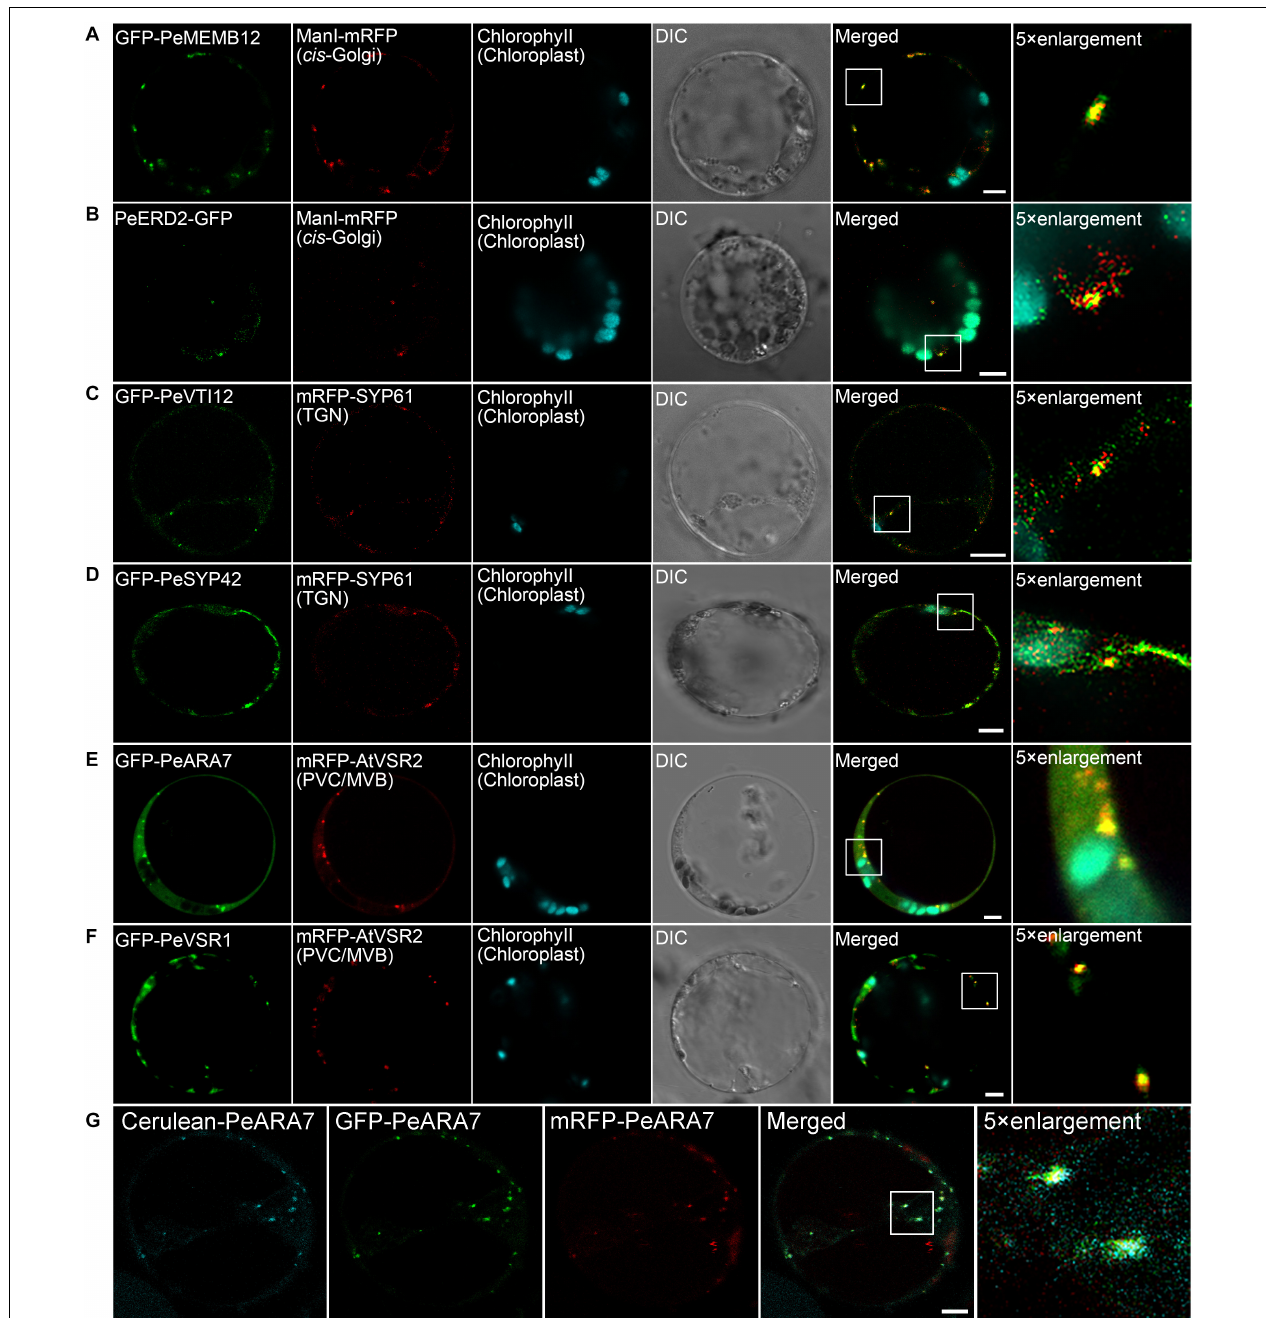
FIGURE 5 | Subcellular localization of endogenous organelle markers in endosomal compartments of moso bamboo. (A,B) Colocalization of GFP–PeMEMB12 (A) or PeERD2–GFP (B) with Arabidopsis cis -Golgi marker ManI–mRFP. (C,D) Colocalization of GFP–PeVTI12 (C) or GFP–PeSYP42 (D) with Arabidopsis TGN marker mRFP–AtSYP61. (E,F) Colocalization of GFP–PeARA7 (E) or GFP–PeVSR1 (F) with Arabidopsis PVC/MVB marker mRFP–AtVSR2. (G) Examples of colocalization signals of the PVC/MVB compartment marker PeARA7 tagged with cerulean (cyan), GFP (green), or mRFP (red) transiently expressed in moso bamboo protoplasts. Note that all three fluorophores allow clear spectral separation, based on their excitation/emission characteristics. DIC, differential interference contrast. Scale bar = 5 µ